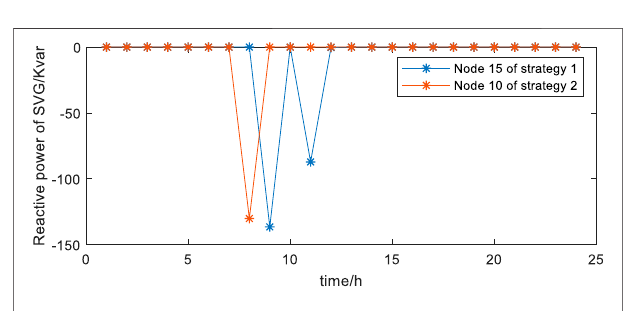
FIGURE 8 | SVG powers for strategy 1 and strategy 2.